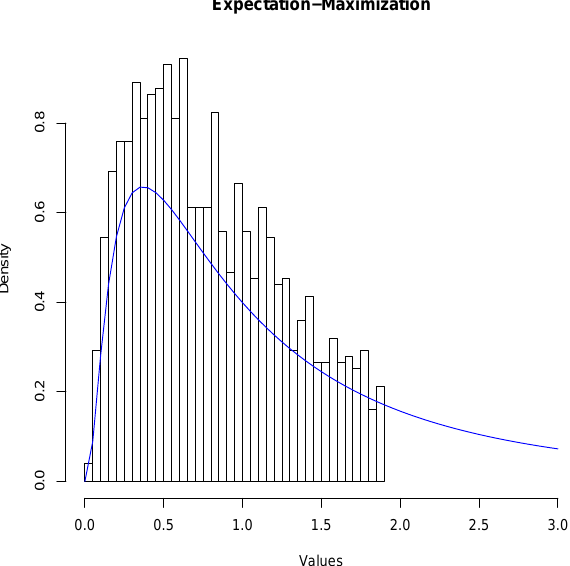
Figure 3. This figure illustrates the creation of the tail of a distribution as the empirical distribution is mechanically truncated and bounded by the maximum value contained in the dataset. To obtain this figure, we randomly generated data points from a lognormal distribution with µ = 0 and σ = 1. All values above 1.9 have been removed to illustrate missing data, and then, the EM algorithm has been used to rebuild a consistent lognormal distribution with appropriate parameters. The x-axis refers to the values represented in the